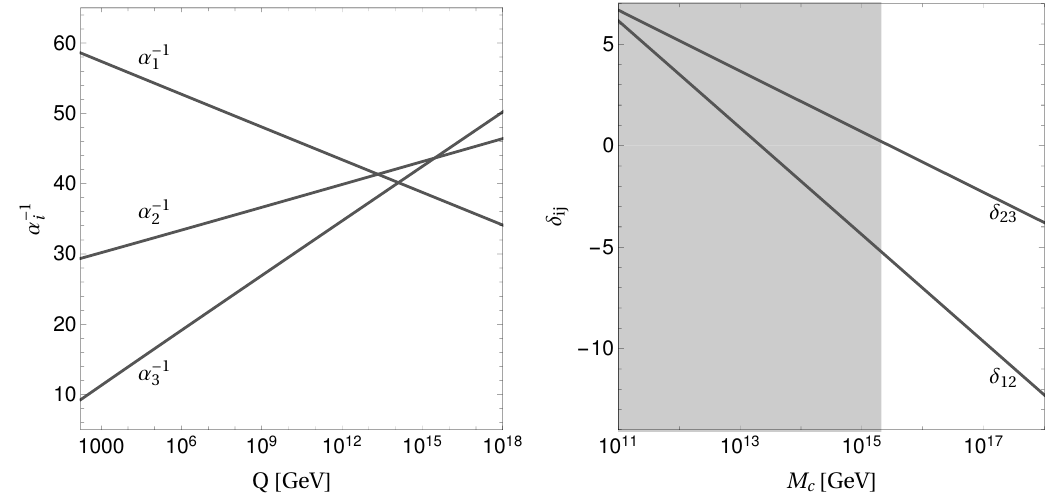
Figure 2 . Left panel: running of (cid:11) (cid:0) 1